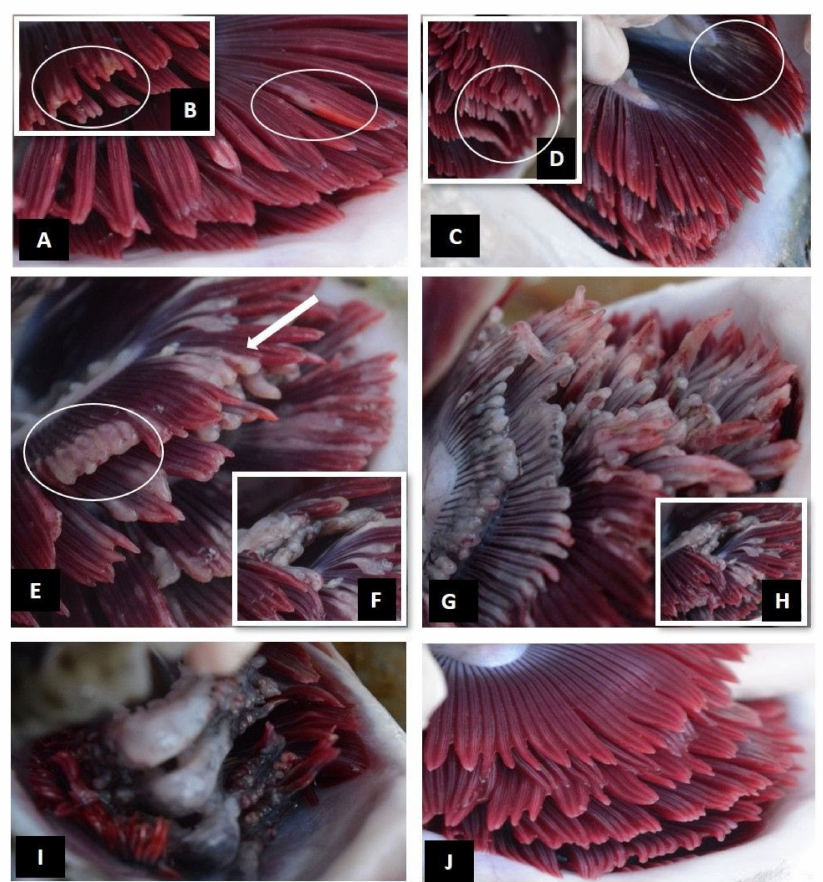
Figure 2. Total gill scoring system for gills of Atlantic salmon displaying multifactorial gill disease. ( A , B ) Score 1—very light: discrete focal white streaks or patches ( A : white circle) on individual filaments and slight erosion/damage to distal ends of filaments ( B : white circle); ( C , D ) score 2—light: more extensive coalescing white streaks or white focal patches on filaments ( C : white circle), extended erosion/damage to distal ends of filaments ( D : white circle); ( E , F ) score 3—moderate: extensive multifilamental peripheral erosion ( D : white circle), grossly swollen or thickened filaments ( D : arrow) with occasional areas of localised areas of necrotic tissue ( F : white circle); ( G , H ) score 4—advanced: extensive, grossly swollen or thickened filaments, shortened filaments (>50% of filament length affected) with areas of necrotic tissue ( H ); ( I ) score 5—severe: widespread necrotic patches, extensive melanisation, almost total destruction of gill architecture due to extensive loss of tissue; ( J ) score